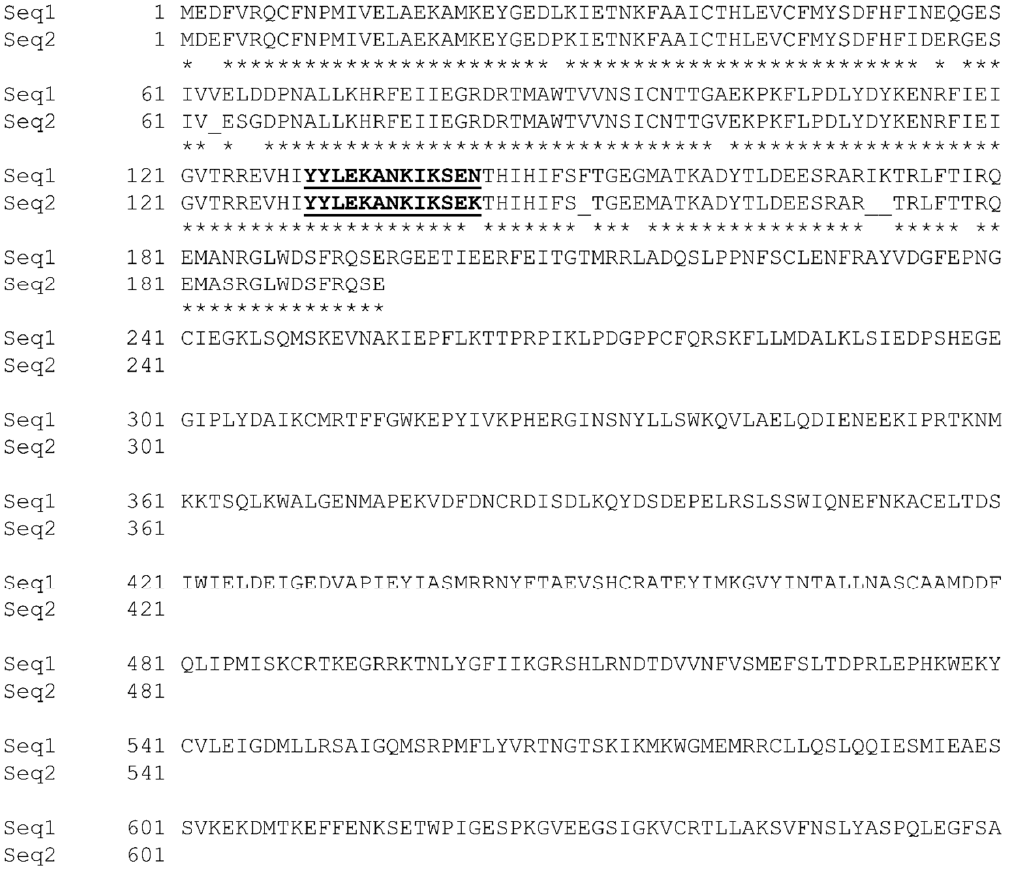
Figure 6. Overlay of the amino-acid sequences; above is the sequence Seq1of the construct used in the inhibition studies, below is the sequence Seq2 for the crystallographic study used in the docking experiment. The binding site 130–138 from the docking study is given in bold and underlined for clarity. * corresponds to retained identities.